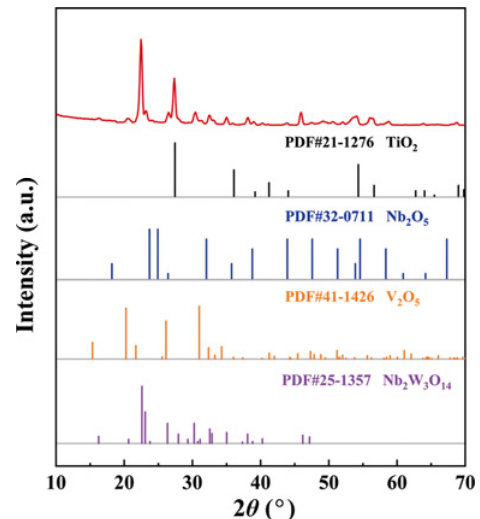
Fig. 13 XRD patterns of non-worn surfaces at 800 ℃ .